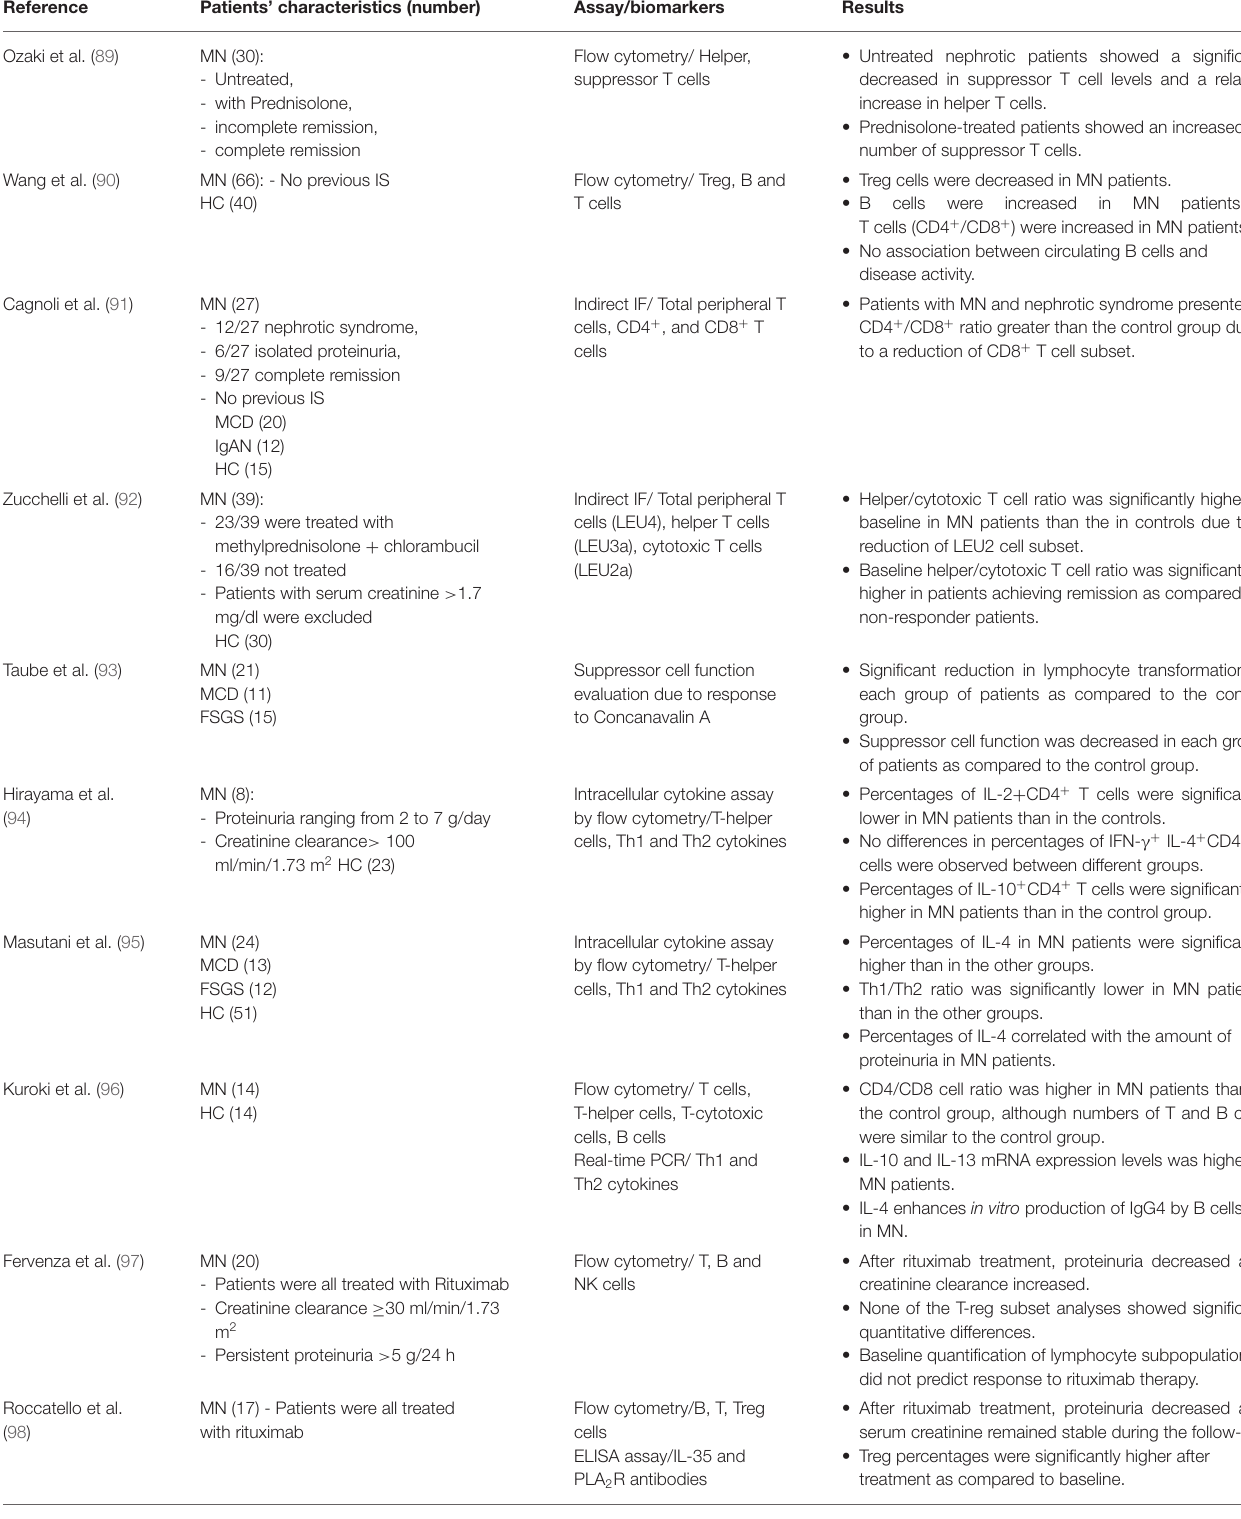
TABLE 1 | Studies on the immune phenotype of patients with membranous nephropathy.